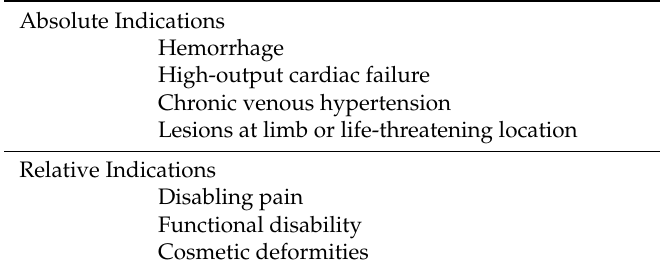
Table 4. Absolute and relative indications of treatment for AVMs [19] .